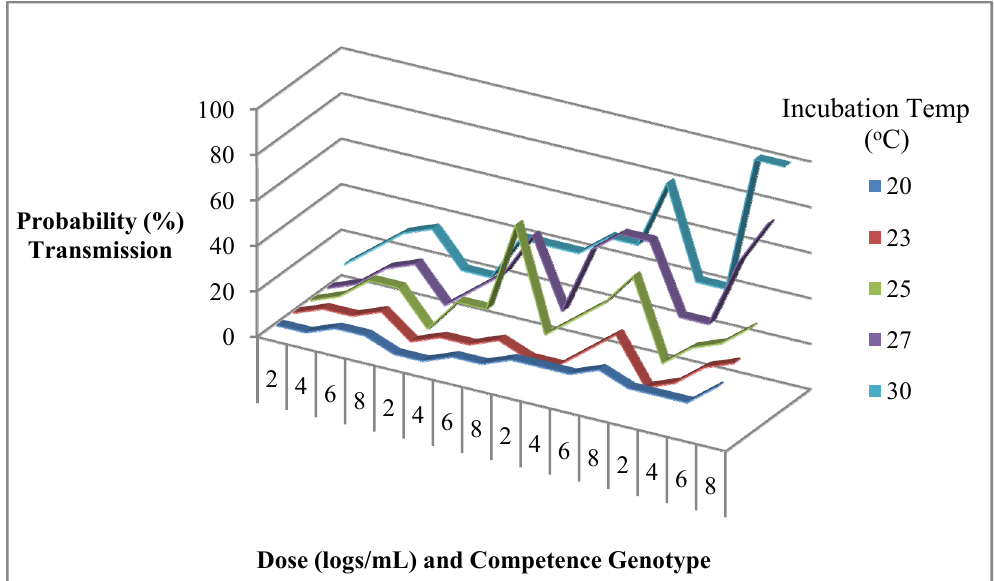
Figure 2. An example of transmission variation that is dependent on non-linear relationships between vector competence genotype, virus dose, and temperature of incubation. The epidemiologic significance of the variations in the probability of transmission such as shown here are